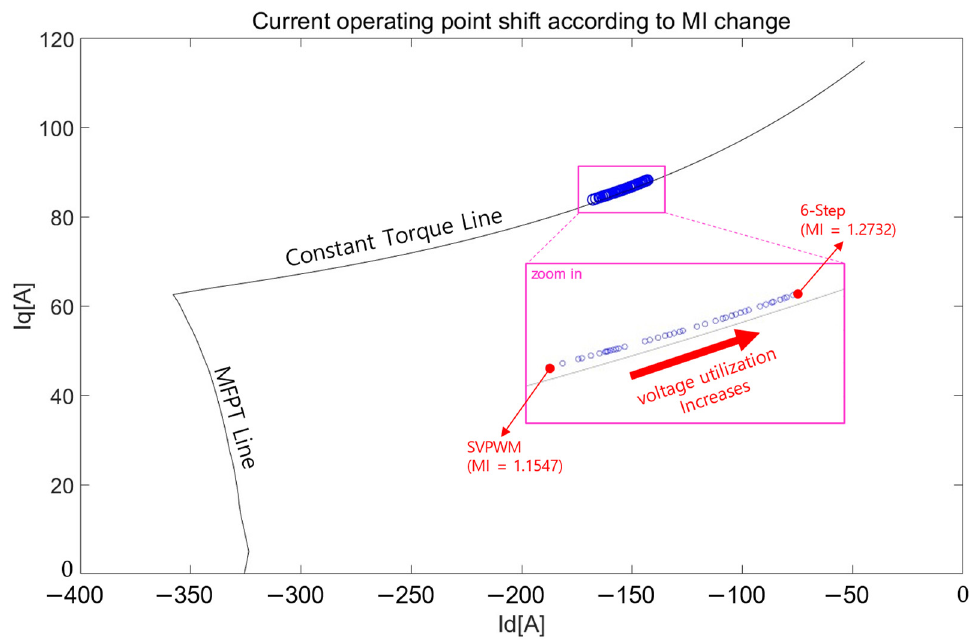
Figure 9. Test point for observing the efficiency change on a constant torque curve.